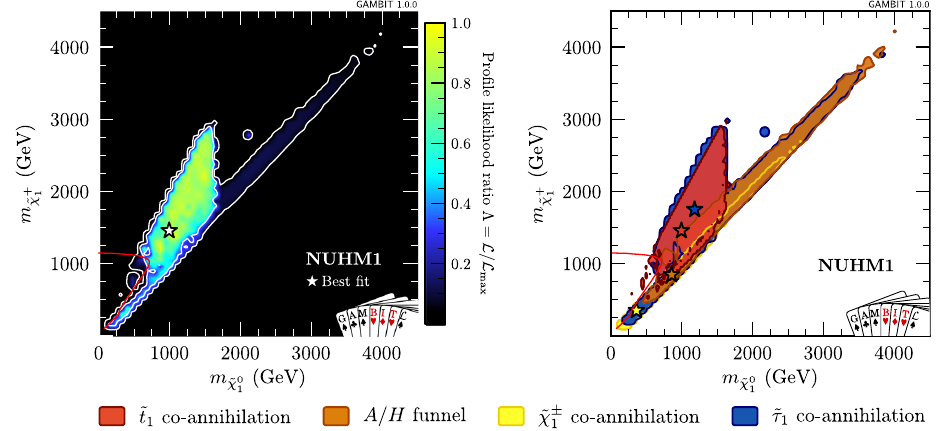
− ˜ χ 0 of DM. Superimposed in red is the latest CMS Run II simplified model mass 1 1 ˜ χ 0 limit for ˜ χ ± pair production and decay via sleptons [328]. This limit 1 1 should be interpreted with caution (for details see main